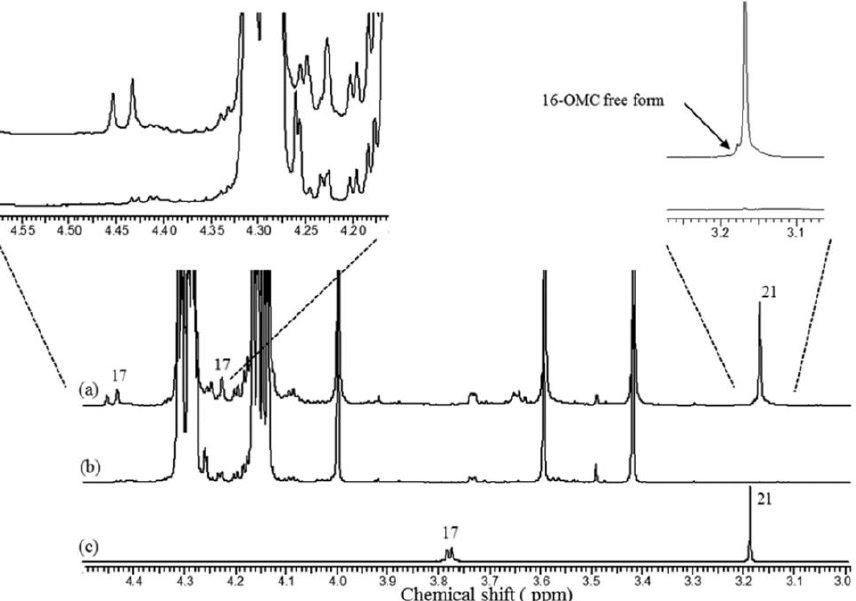
Figure 7. Expanded region of the 1 H NMR spectrum showing the diagnostic resonances of protons 17 and 21: ( a ) 100% Robusta sample, ( b ) 100% Arabica sample, and ( c ) 16-OMC standard. In the insets on the top of the figure, the signals of protons 17 and 21 of 16-OMC ester are enlarged. They are clearly visible in the Robusta sample (top), but they are absent from the Arabica sample. The arrow shows the weak methyl signals in position 21 of 16-OMC in its free form (Adapted with permission from [39]. Copyright 2014, American Chemical Society).